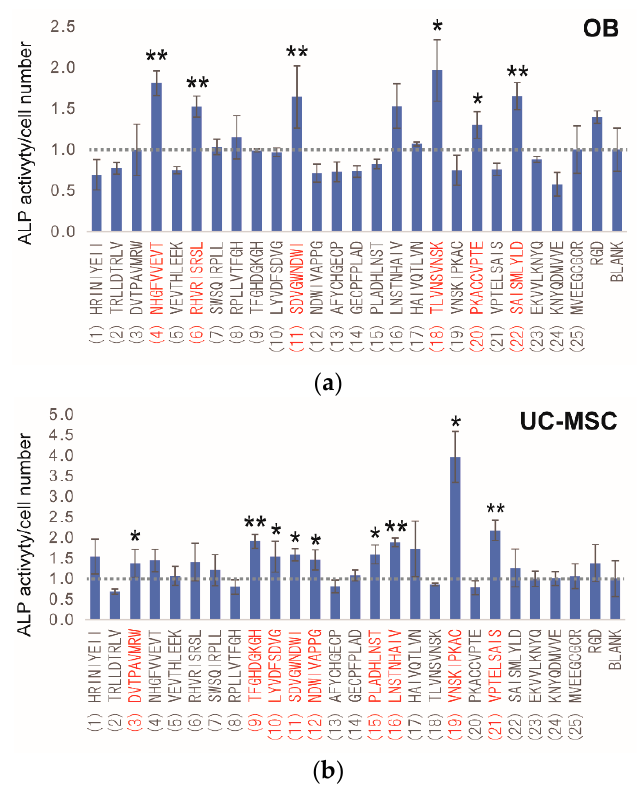
Figure 5. Results of ALP activity per unit cell number. The value was calculated by dividing the ALP activity by cell number and normalized to Blank (value of no peptide = 1.0). ( a ) OBs; ( b ) UC-MSCs. All experiments were performed in triplicate. * Denotes statistical significance compared to Blank (no peptide), p < 0.05, Student’s t -test. ** Denotes statistical significance compared to Blank, p < 0.01, Student’s t -test.